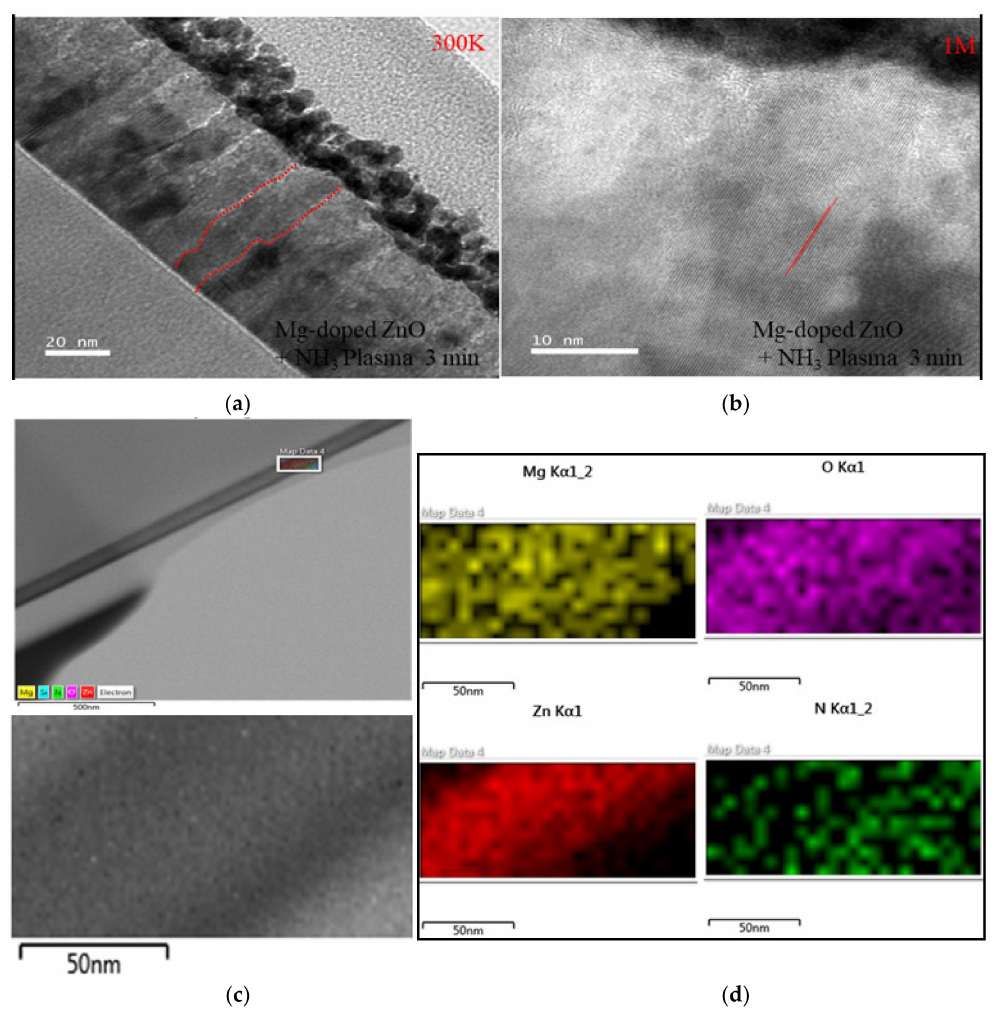
Figure 4. ( a , b ) MZO thin film TEM and EDS profiles of samples treated with NH 3 plasma. ( c , d ) EDS analysis of MZO thin film with NH 3 plasma at 3